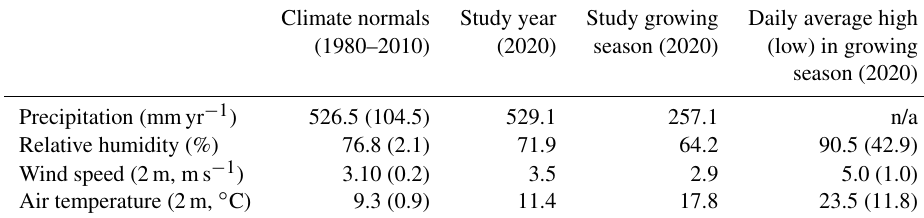
Table 1. Climate conditions at a nearby long-term weather station, Berlin Brandenburg Airport (DWD, 2021). Average (standard deviation in round brackets) climate conditions are shown for the climate normals (1980–2010) and the study year (2020). The growing season is May–September (inclusive). n/a is not